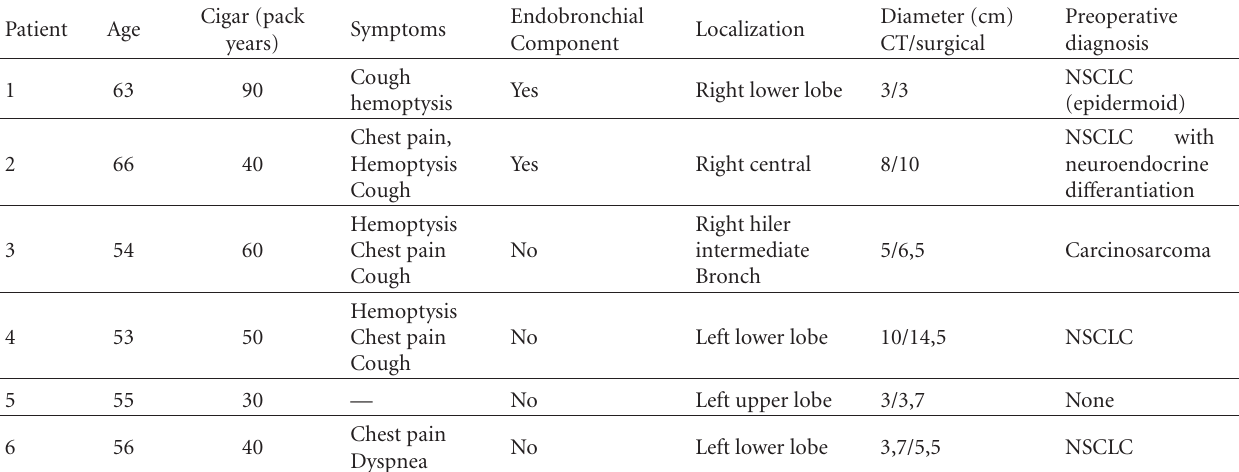
Table 1: Characteristics of the patients.